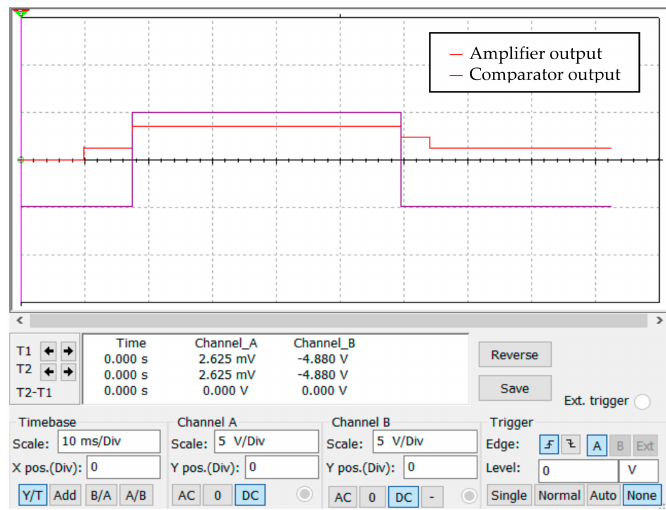
Figure 12. Optimized circuit simulation output